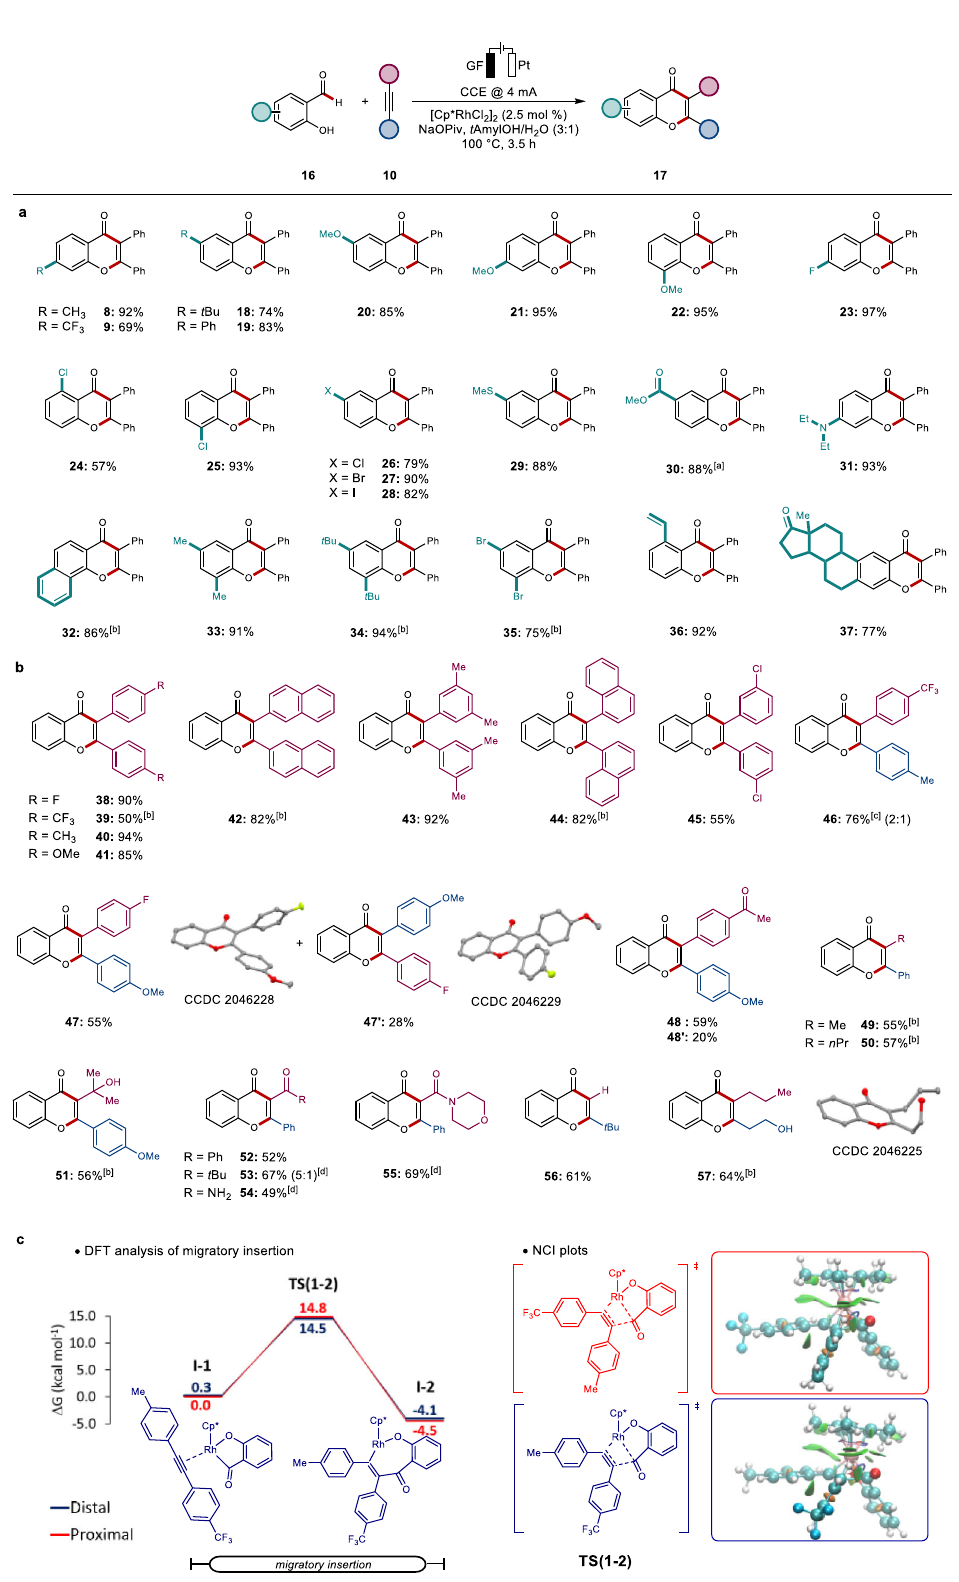
Fig. 4 Versatility of the rhodaelectro-catalyzed assembly of chromones and computational studies on the origin of regioselectivity. a Aldehyde scope for various substituents. b Scope of viable alkynes. c Calculated energy pro fi les for the regioselective determining step for the Me/CF 3 substituted alkyne at the PW6B95-D3(BJ)/def2-QZVP + SMD(methanol)//PBE0-D3(BJ)/def2-SVP level of theory and spatial localization of noncovalent interactions in the transition states. In the latter, red indicate repulsive interactions, with blue and green being attributed to strong and weak attractive interactions. a With n Bu b 7 h. c Ratio determined by 19 F-NMR. d With 5.0 mol % [Cp*RhCl 4 NPF 6 (0.1 Μ ) instead of H 2 O. 2 ] 2